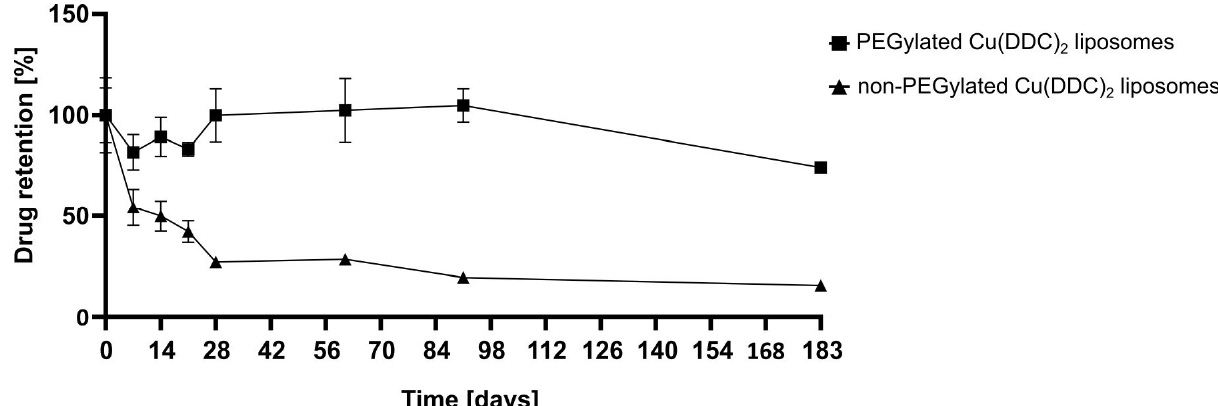
Figure 4. Liposomal Cu(DDC) 2 retention upon storage at 4–6 °C. Aliquots of non-PEGylated and PEGylated Cu(DDC) 2 liposomes (8 mM total lipid) were stored at 4–6 °C for 6 months (183 days). Samples were filtered through a 0.2-µm CA filter after specific storage time points. The D/L ratio of Cu(DDC) 2 liposomes was determined before and after the filtration step. A reduction of the D/L ratio indicated Cu(DDC) 2 release from liposomes. Data are expressed as the mean ± SD ( n = 3).